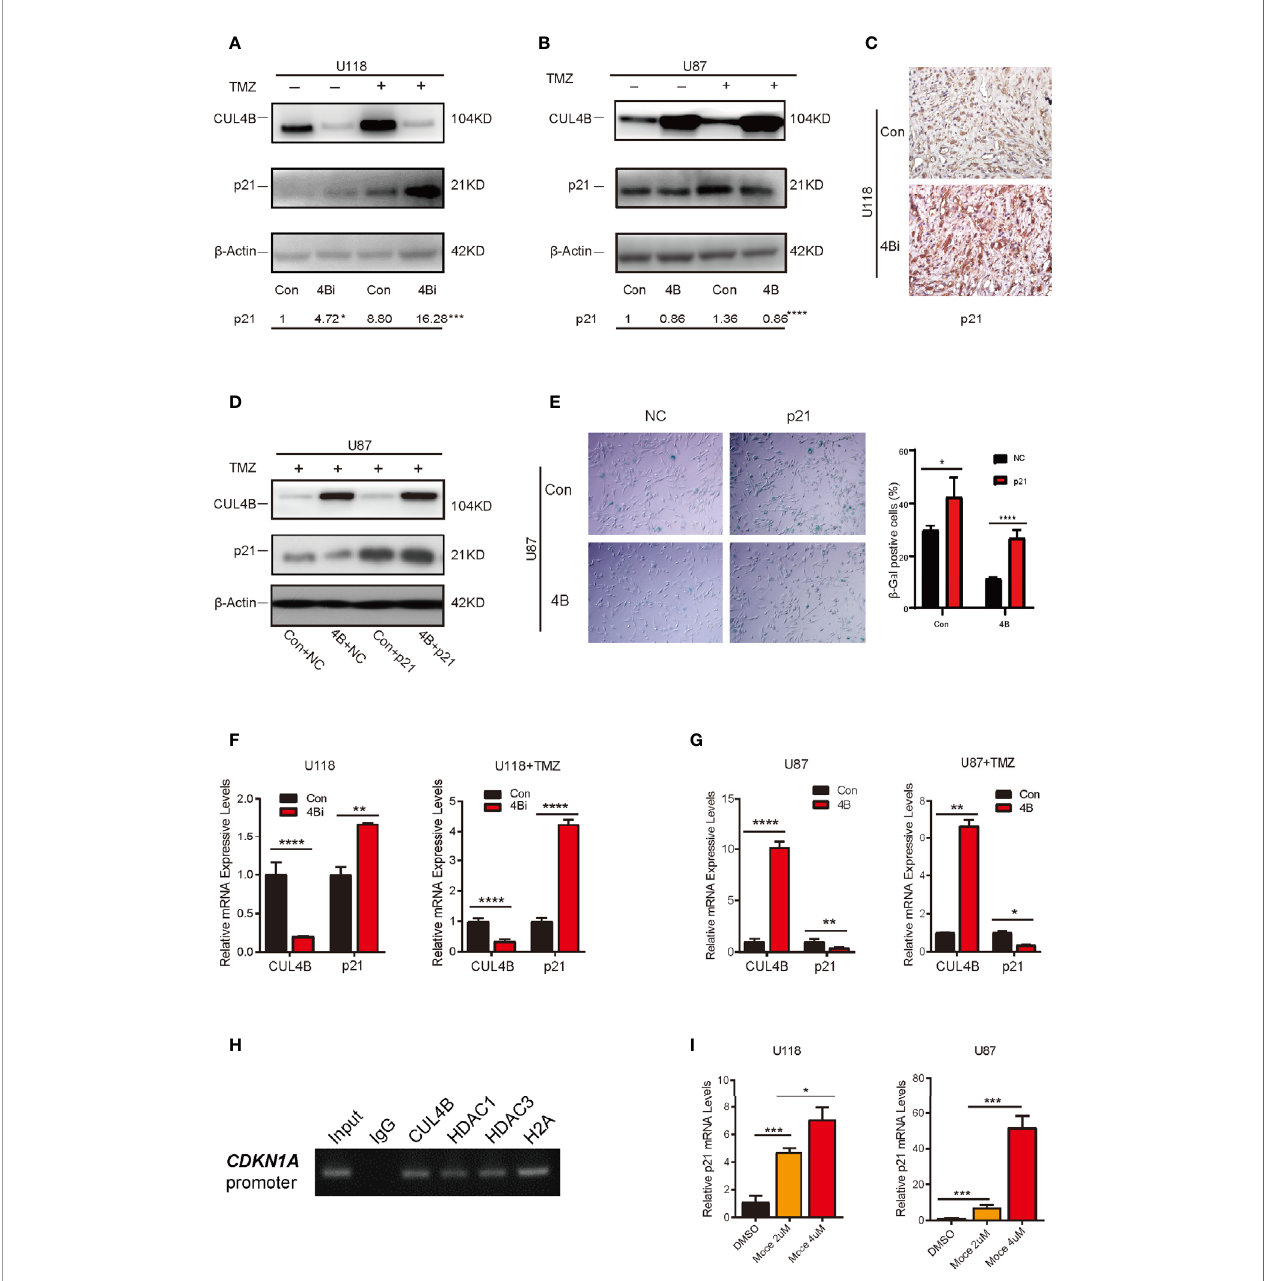
FIGURE 5 | CUL4B attenuates TMZ-induced senescence through repressing CDKN1A transcription. (A, B) p21 expression in indicated U118 (A) and U87 (B) cells with or without TMZ treatment. The numbers shown below Western blot images are means of band intensities relative to control without TMZ treatment. Signals on the immunoblots were analyzed by ImageJ, normalized with that of b -actin. (C) Representative images of IHC staining of expression of p21 in indicated cells in tumors from nude mice. (D) Western blot analysis of indicated proteins in indicated U87cells. (E) SA- b -galactosidase staining assays of indicated U87 cells after TMZ treatment. (F, G) qRT-qPCR analysis of p21 mRNA expression in U118 cells (F) and U87 cells (G) with or without TMZ treatment. (H) ChIP assays of the recruitment of indicated proteins at the p21 promoter in U87 cells. (I) Effects of histone deacetylase (HDAC) inhibitors Mocetinostat (Moce) on p21 mRNA levels in U118 and U87 cells. (****P < 0.0001, ***P < 0.001, **P < 0.01; *P <